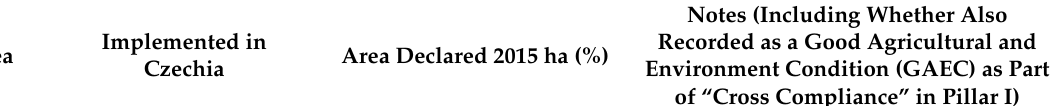
Table 4. Ecological Focused Areas implemented in the Czech Republic by 2016 as part of “greening” rules and cross-compliance measures